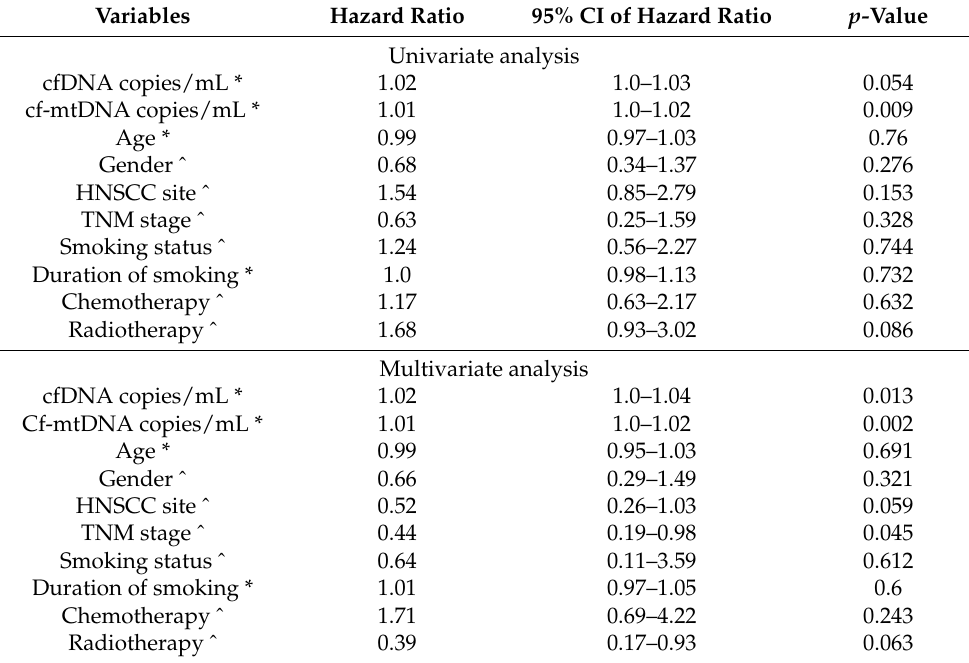
Table 3. Cox proportional hazards regression analysis based on several prognostic variables, showing p -values, hazard ratios, and 95% confidence